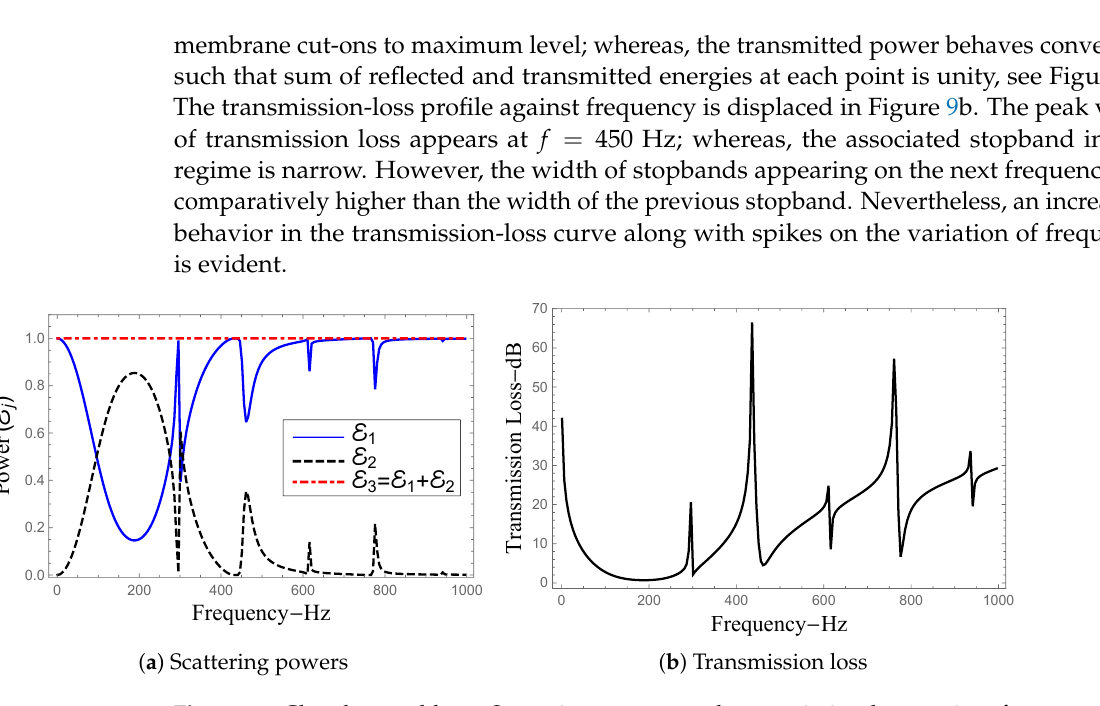
Figure 9. Chamber problem: Scattering powers and transmission loss against frequency with ¯ a = 0.05 m, ¯ b = 0.1 m and ¯ L = 0.05 m.